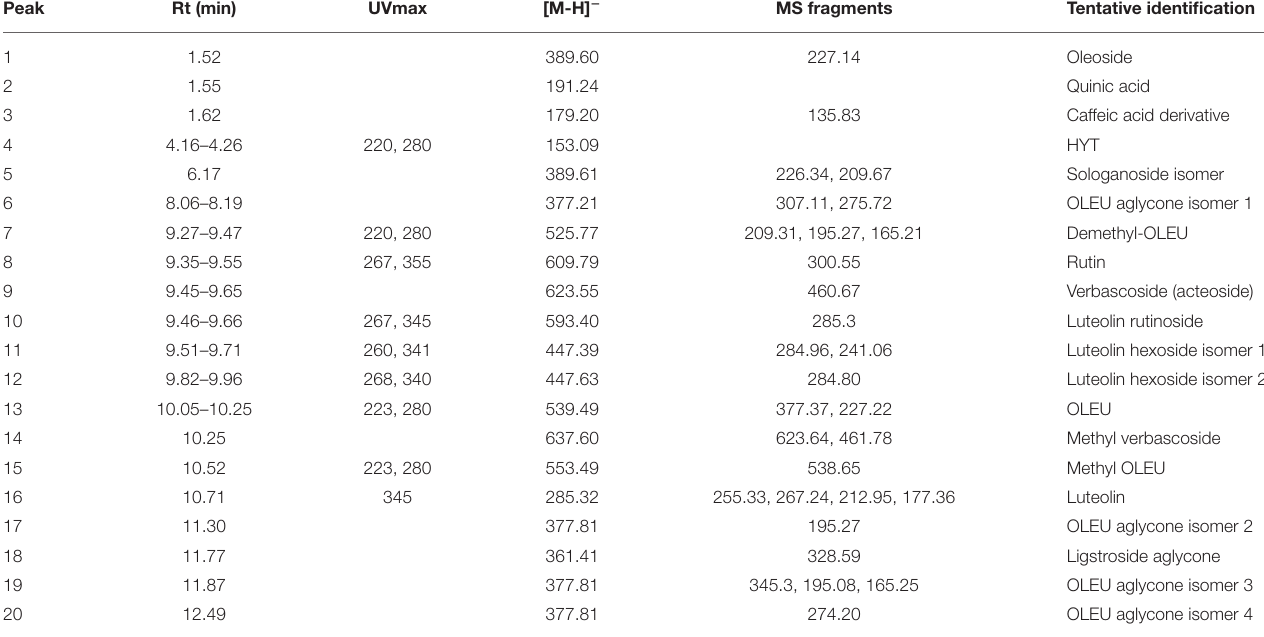
TABLE 3 | Tentative identification of the components of the OLEU-EE from olive mill leaves.